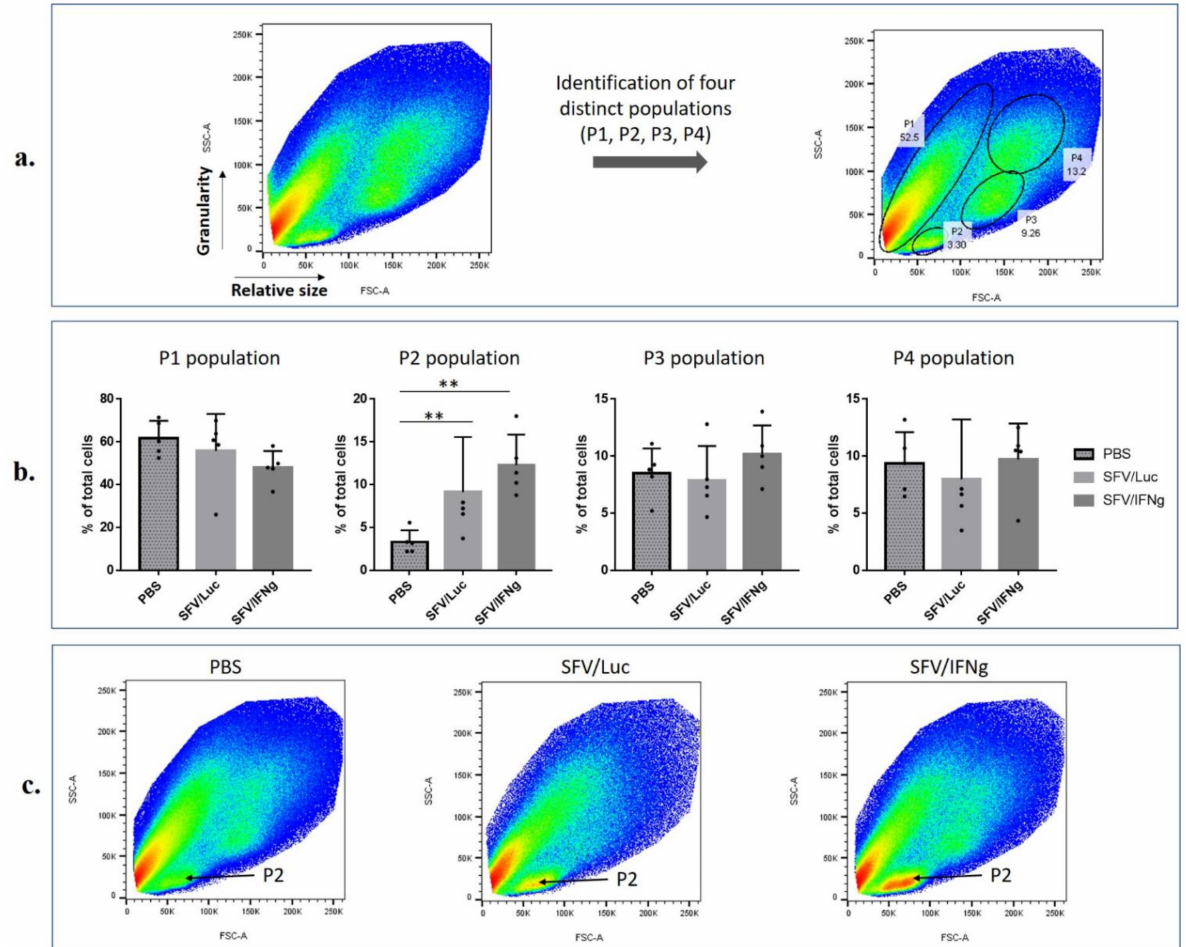
Figure 7. Flow cytometry of the 4T1 tumors treated with SFV/IFNg, SFV/Luc or PBS (mice were treated as presented in Figure 6d). Tumors were resected, homogenized to obtain a single cell suspension, and the total isolated cells were subjected for immunostaning followed by analysis of forward and side (SSC-A/FSC-A) scattering of cell populations. ( a ) Schematic representation of the identification of four distinct single-cell populations (representative pictures). ( b ) Percentage of the respective populations within total single cells (five mice per group). ( c ) Representative SSC-A/FSC-A data from the PBS, SFV/Luc, and SFV/IFNg groups. The pronounced P2 populations are indicated by arrows. Bars represent the means ± SD ( n = 5); ** p <